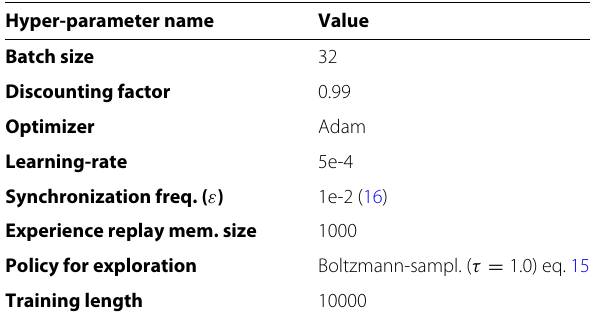
Table 2 Hyper-parameters of the RL